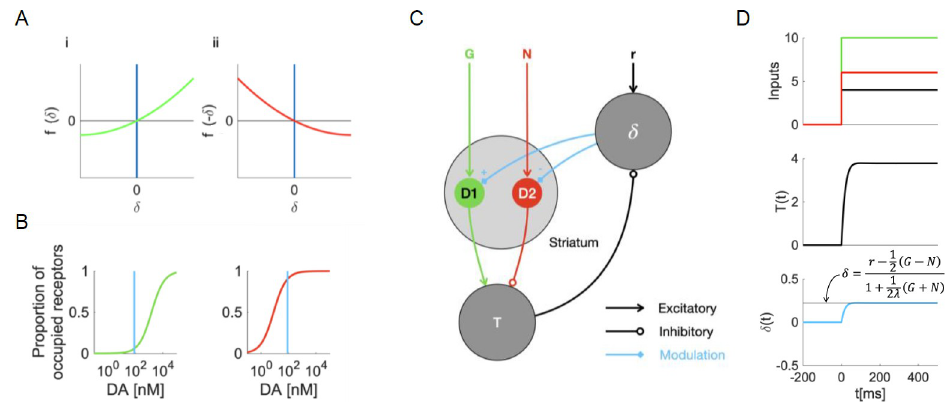
Fig 4. Plasticity and computations in the basal ganglia circuit. A The nonlinear transformation of dopaminergic prediction errors in the SPE model. The transformation in the direct pathway (i) and the transformation in the indirect pathway (ii) are mirror images of each other. B We plot the proportion of occupied receptors in the striatum as a function of dopamine concentration. The curves are based on the results of Dreyer, Herrik [26]. The blue vertical lines indicate the baseline dopamine concentration in the ventral striatum, based on the results of Dodson, Dreyer [27]. The green curve corresponds to the occupancy of D1 receptors, the red curve corresponds to the occupancy of D2 receptors. Panel B is adapted from figure 3D of Mo¨ller and Bogacz [23]. C The connectivity underlying a dynamical model of the simplified basal ganglia circuit. Circles correspond to neural populations; arrows between them indicate connections. D The computation of a scaled prediction error in continuous time, according to a dynamical model of the basal ganglia. We show how the relevant variables, T and δ , evolve as a function of time, assuming a step–function activation for the input nodes G , N and r . The black line in the lowest panel indicates the level of dopamine required for exact SPE